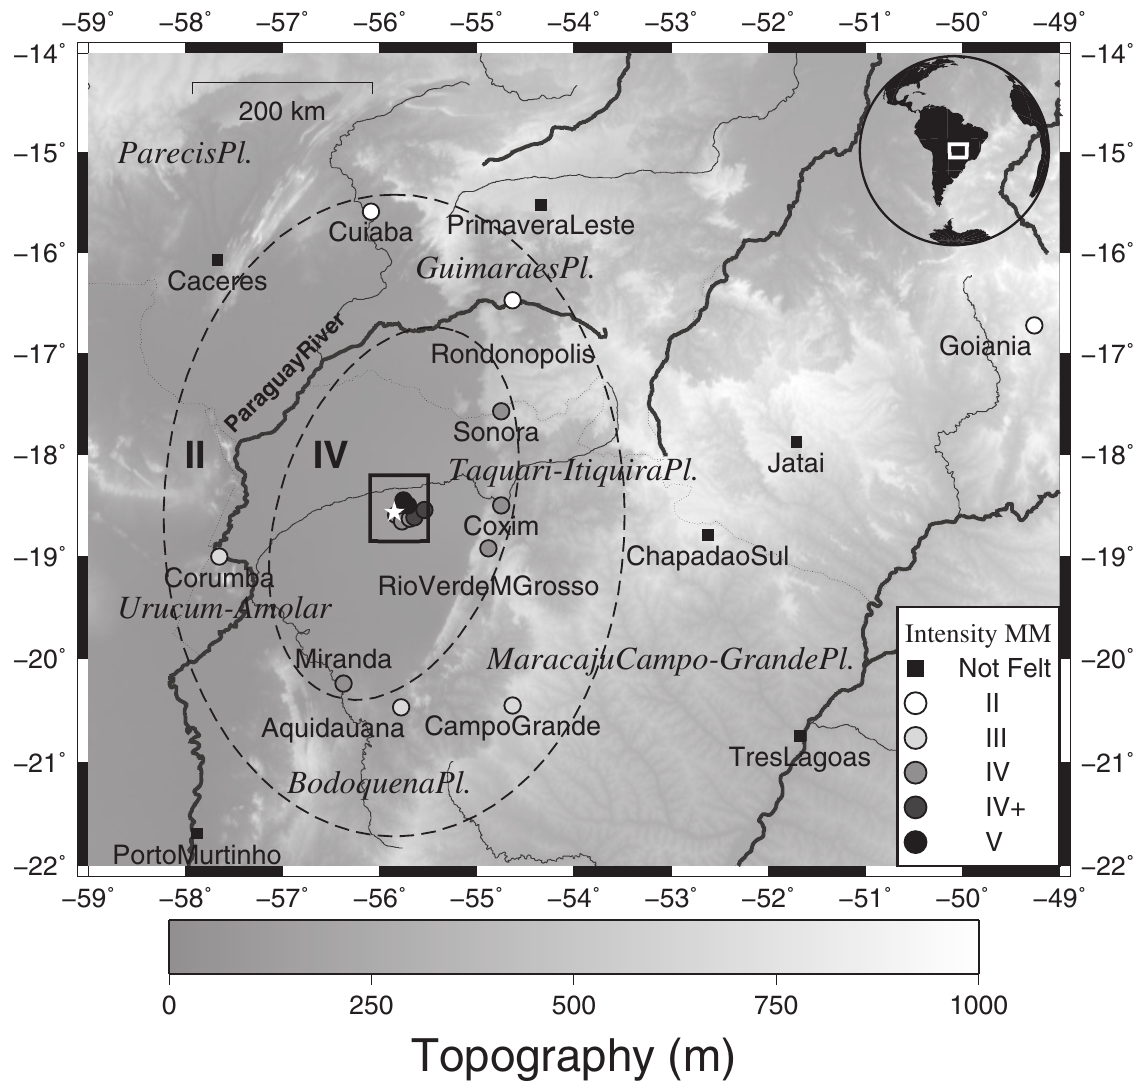
Figure 2 - Map of earthquake intensity Coxim earthquake (star). The color of the circles represents the different intensities felt by the population. The large and small ellipses are lines isoseismal MM II and MM IV, respectively. Black squares are major cities in the region where the tremor was not felt. The principal plateaus (Pl.) and the hydrography are also shown. The square in epicentral region corresponds to Fig.